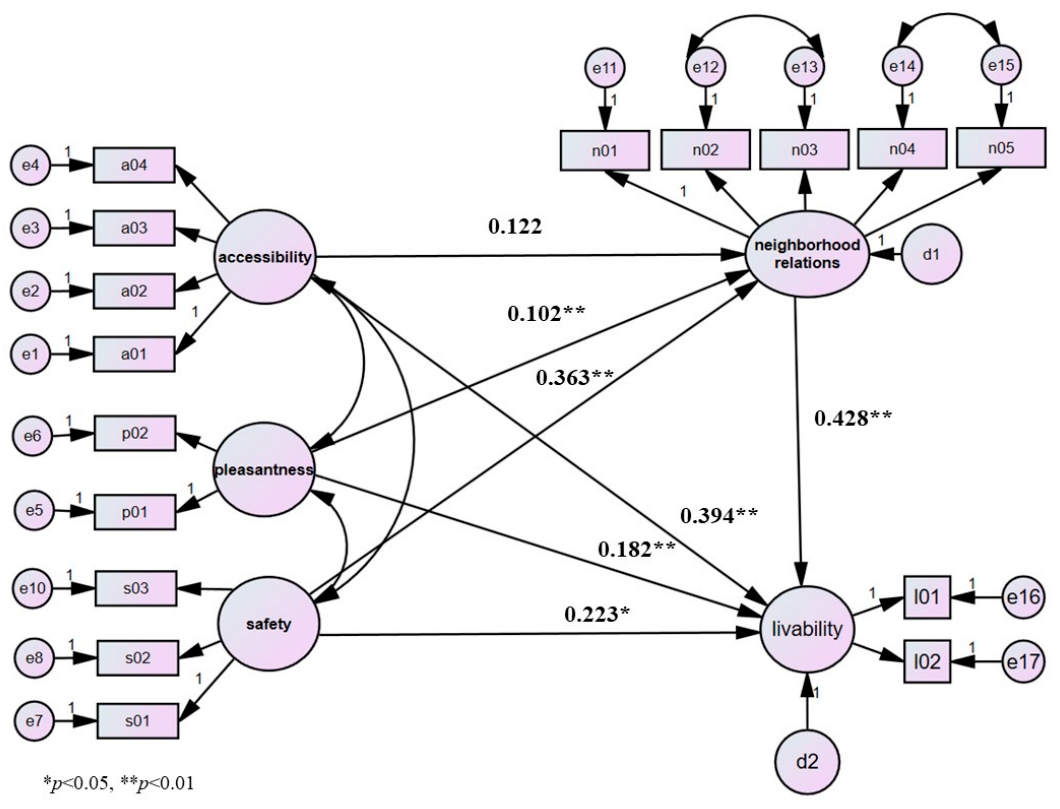
Figure 3. Structural equation model (SEM) (1) a01~a04, p01~p02, s01~s03, n01~n05, l01~l02: measurements; (2) e1~e17: measurement error; (3) d1~d2: structural error.